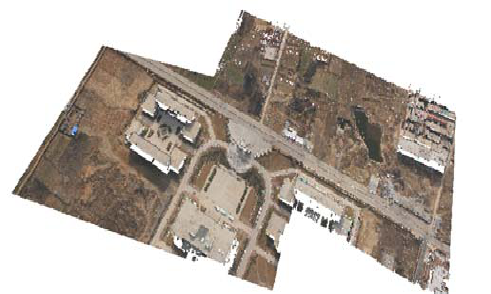
Figure 4. The 3D point cloud resulting from two epipolar image pairs in